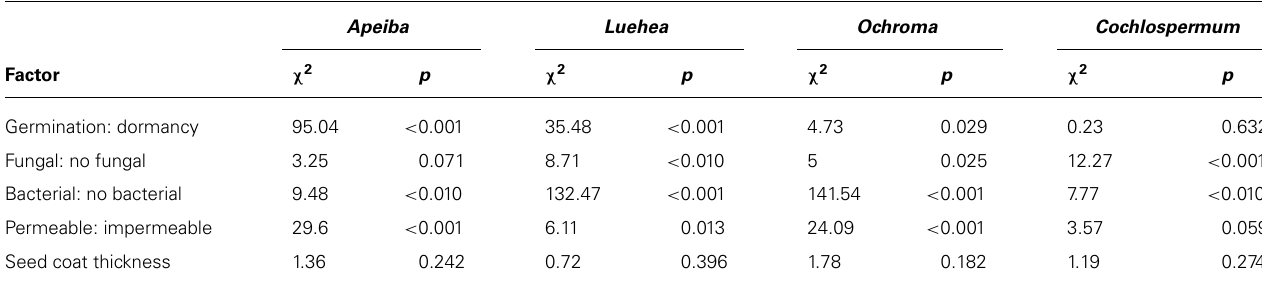
Table 2 | Results of generalized linear mixed-effects models for each